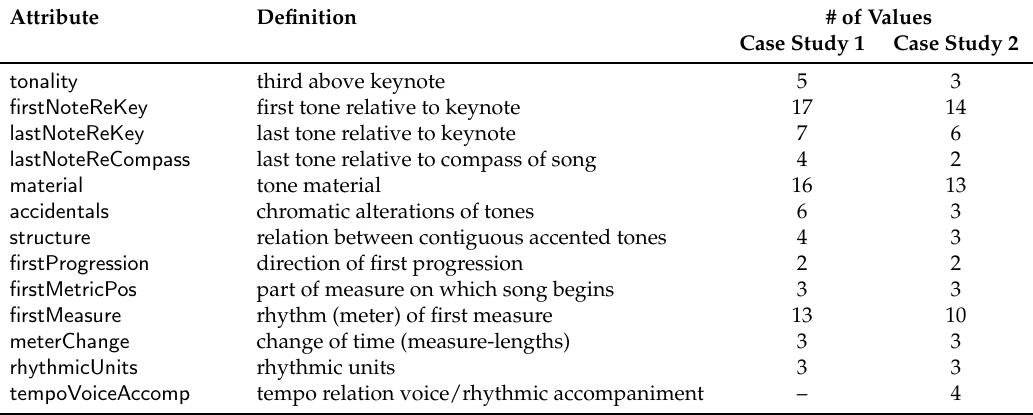
Table 3. Music content features based on Densmore’s quantitative